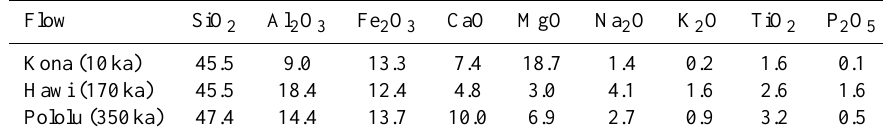
Table 2. Composition (mass fraction (%)) of three laval flows taken from Porder and Chadwick (2009).